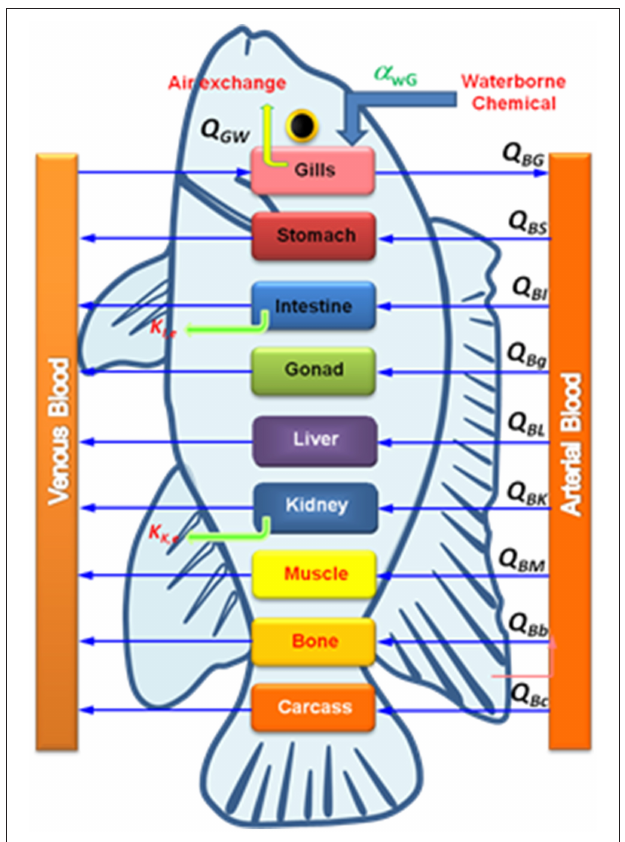
FIGURE 2 | Scheme of a PBPK model for NPs in fish where Q Gw is the gill-water exchange rate, Q Bi is the blood-tissue exchange rate, and k i is the elimination